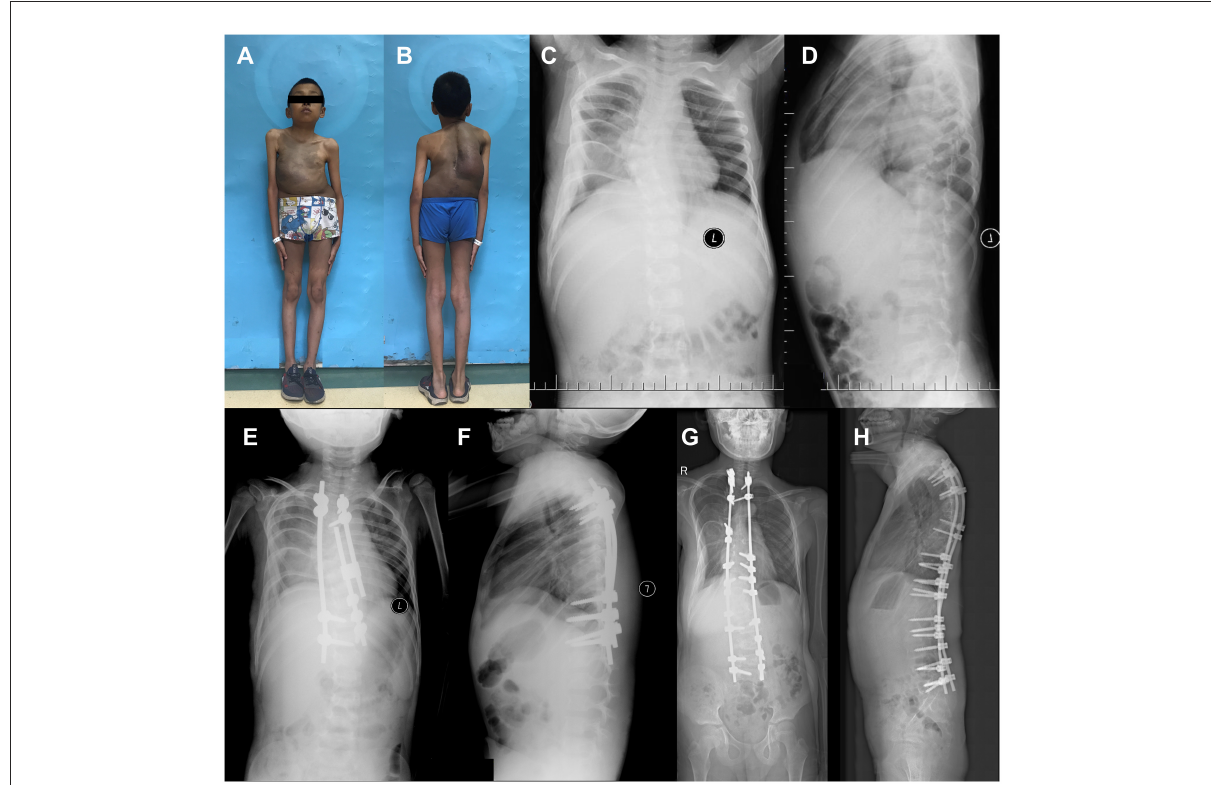
FIGURE3 Surgical treatment of 4-year-old NF1 associated dystrophic scoliosis patient 11. (A,B) Patient 11 had large café-au-lait spots on the trunk, scattered café-au-lait spots on the limb, and scoliosis. (C,D) X-ray of spine showed scoliosis with apical vertebrae located in T6 causing 35.0 ◦ Cobb angle, dystrophic changes at T5-T7 vertebrae when patient was 4 years old. (E,F) After surgery, X-ray showed that Cobb angle was 10.0 ◦ . (G,H) After definitive fusion, patient’s Cobb angle was 10.0 ◦ at 12 years and 7 months old. T, thoracic